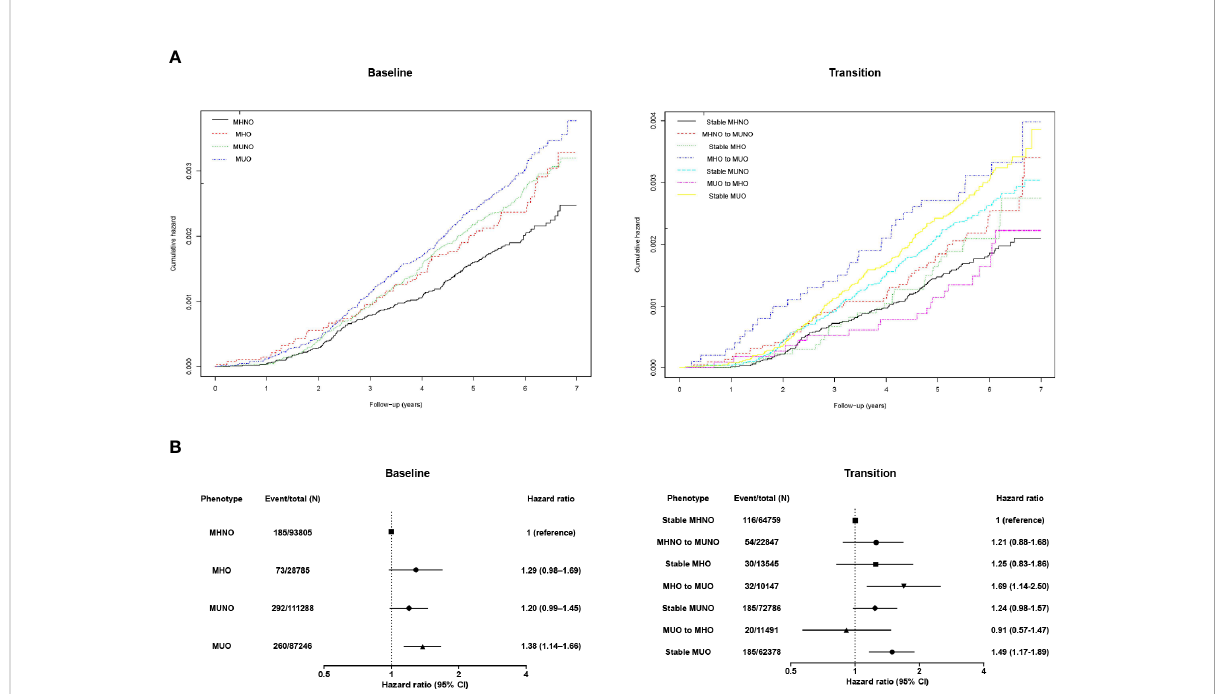
FIGURE 1 (A) Kaplan – Meier curves and the (B) hazard ratios (95% con fi dence intervals) for kidney cancer according to obese metabolic health status at baseline and in consideration of phenotypic transitions. The hazard ratios (95% con fi dence intervals) were adjusted for baseline age, sex,